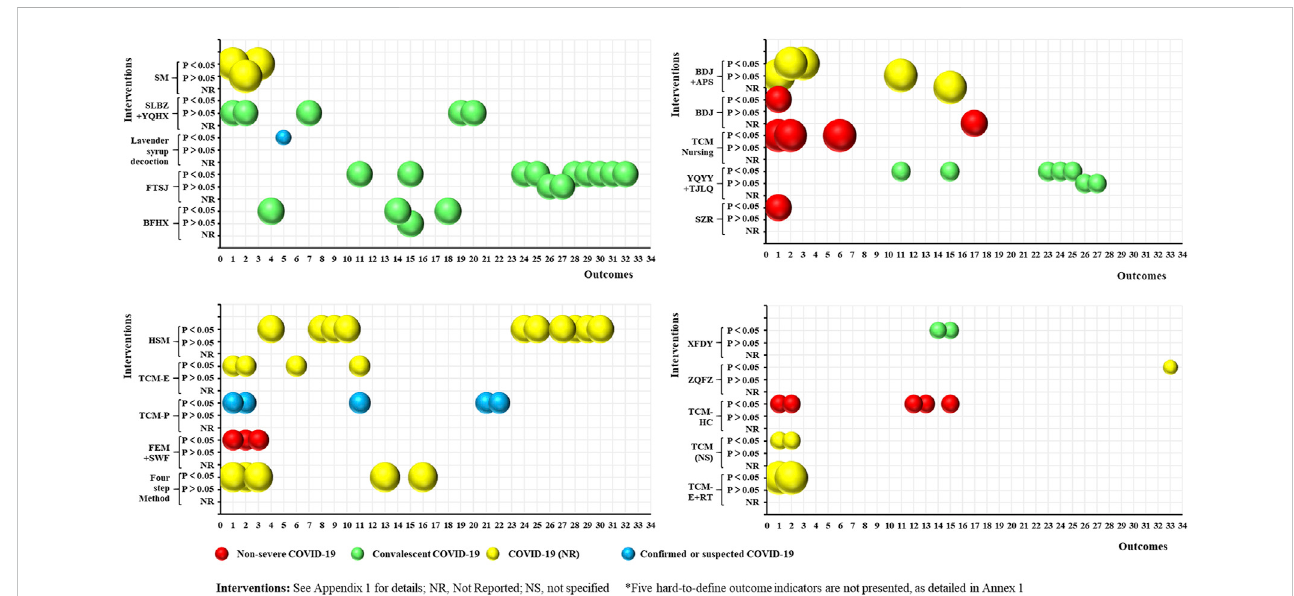
FIGURE 6 EvidencemappingofTCMinterventionsinCOVID-19rehabilitationRCTs.Outcomecodes:Anxietyscore(1);Depressionscore(2);Sleepqualityscale(3); 6-Min Walk Distance (4); Olfactory dysfunction (5); Patient satisfaction (6); QOL (7); Skeletal muscle index (8); Grip strength (9); Balance function (10); Total effective rate (11); Disease aggravation rate (12); Duration of hospitalization (13); Chest CT manifestations (14); TCM syndrome score (15); Time to viral assay conversion (16); Fatigue recovery rate (17); Fatigue Assessment Inventory score(18); Recurrence of SARS-CoV-2 viral RNA positive (19); Abnormality rate of chest CT manifestations (20); Stress scores (21); The TCM Five Emotions (22); Peak expiratory fl ow (23); and Immune Function Indexes: CD3 (24), CD4 (25), CD8 (26), CD4/CD8 (27), IgA (28), IgG (29), IgM (30), C3 (31), C4 (32), and Immune Function